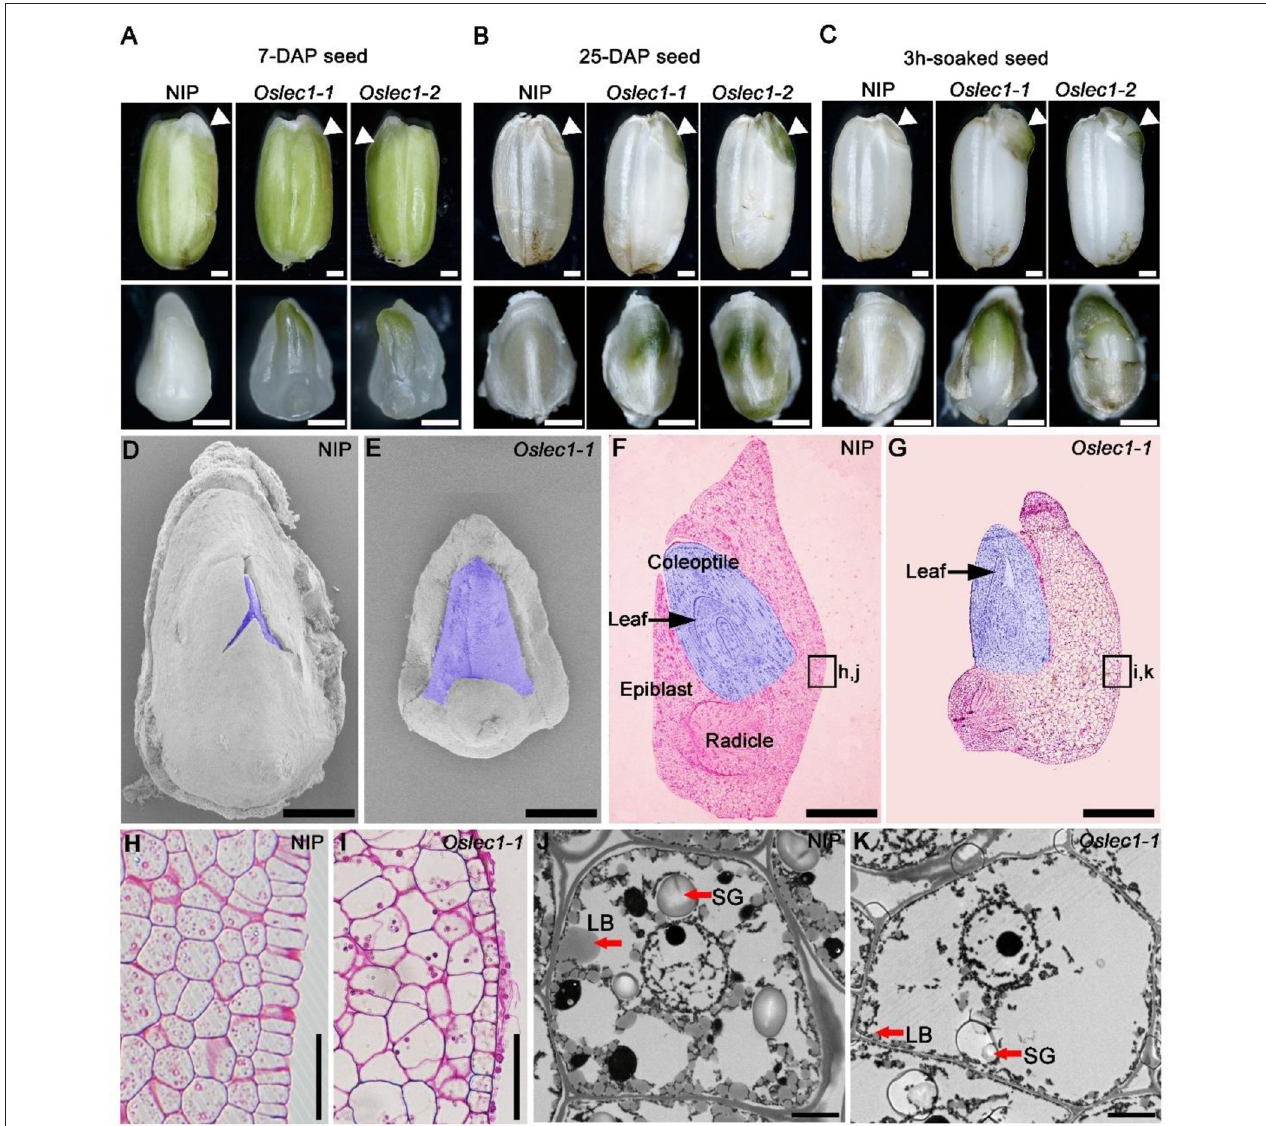
FIGURE 2 | Phenotypes of the developing seeds of Oslec1 mutants. (A) Seeds and embryos (7-DAG) of wild type plants and Oslec1 mutants. (B) Seeds and embryos (25-DAP) of wild type plants and Oslec1 mutants. (C) Seeds and embryos of wild type plants and Oslec1 mutants soaked in water for 3h at 37 ◦ C. Scale bars = 500 µ m. White triangles indicate the embryonic regions in complete seeds. (D,E) Scanning electron micrographs of embryos (7-DAP) of wild type plants and Oslec1 mutants. The purple-colored regions indicate the germs of wild type plants and Oslec1 mutants. Bars = 500 µ m. (F,G) Longitudinal resin sections of embryos (7-DAP) of wild type plants and Oslec1 mutants. The purple-colored regions indicate the germs of wild type plants and Oslec1 mutants. Black arrows indicate the leaves in the coleoptiles. The leaves of Oslec1 mutants are stretched out, and the epiblast wrapping the coleoptile is missing. Scale bars = 500 µ m. (H,I) Amplification of the regions in black boxes in F and G, showing the difference in scutella parenchyma between the wild type and Oslec1-1 mutant. Scale bars = 50 µ m. (J,K) Electron micrographs of wild type and Oslec1-1 embryos. Wild type (J) and Oslec1-1 (K) scutellum sections from 7-DAP embryos. Scale bars = 2 µ m.